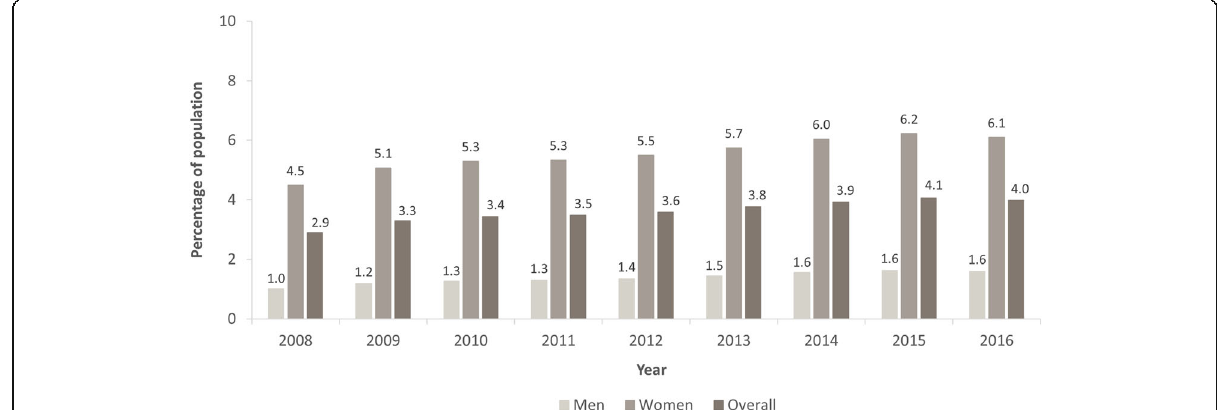
Fig. 4 Extrapolated administrative prevalence of migraine over time by sex in the total German Statutory Health Insurance system population. Overall prevalence values are weighted means, adjusted for sex; 95% confidence intervals are not displayed due to their narrow width